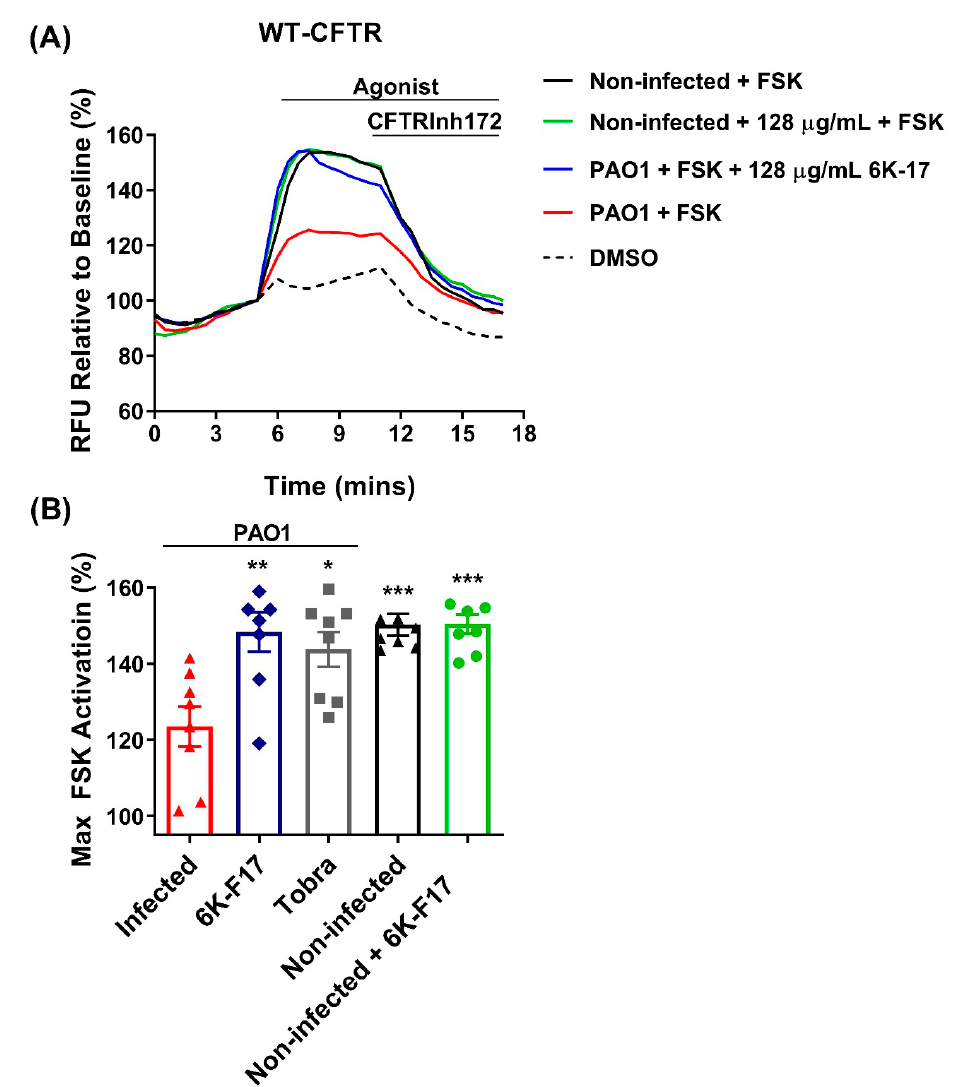
Figure 2. 6K-F17 restores WT channel activity in human bronchial epithelial cells infected with P. aeruginosa . WT CFTR HBE cells were incubated with 6K-F17 peptide alone (128 µg/mL) or with PAO1 bacteria +/ − 6K-F17 peptide (128 µg/mL) or tobramycin (10 µg/mL) for 4 h at 37 °C. ( A ) Representative traces of WT-CFTR dependent chloride efflux while using the membrane depolarization assay. Following a 5 min. baseline measurement, 10 µM Forskolin (FSK) was added. After 10 min, CFTR inhibitor (CFTRinh-172, 10 µM) was added to deactivate CFTR, as noted by the change in the slope of the curves. ( B ) Bar graphs show the mean (±SEM) of maximal activation of CFTR after stimulation by FSK ( n = 7–8; each dot represents one biological replicate). (* p < 0.05, ** p < 0.01, *** p < 0.001).